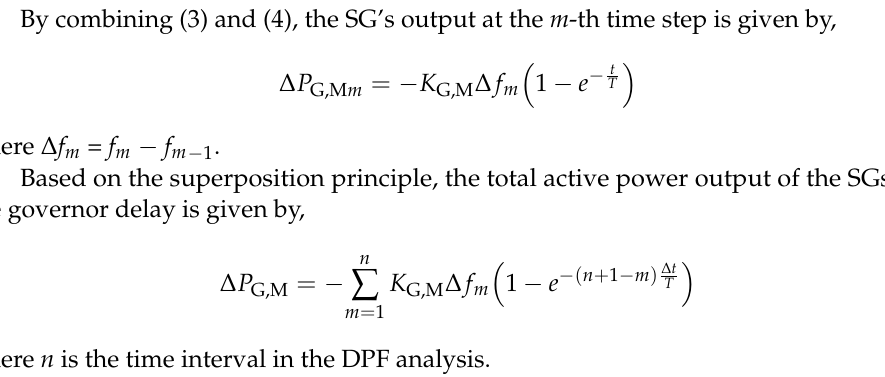
Figure 2. Change of active power output target of SG at time steps of DPF model.